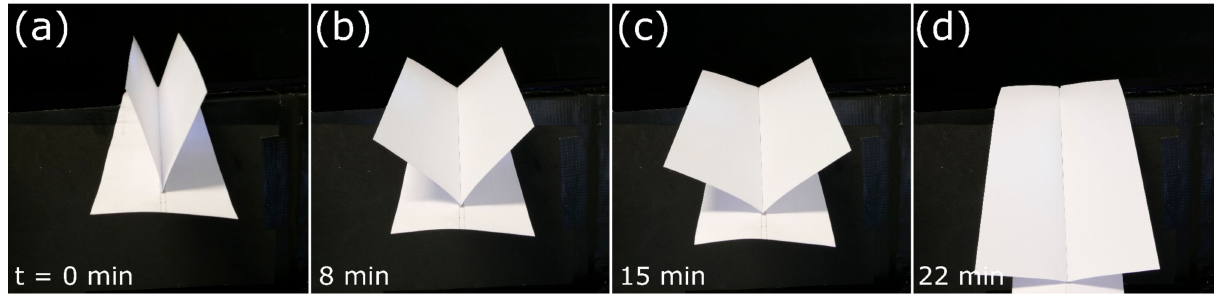
Figure 11. A self-actuated paper-based compliant system inspired by the bird of paradise flower ( S. reginae ). ( a – d ) Opening sequence during desiccation. Time is indicated bottom left.